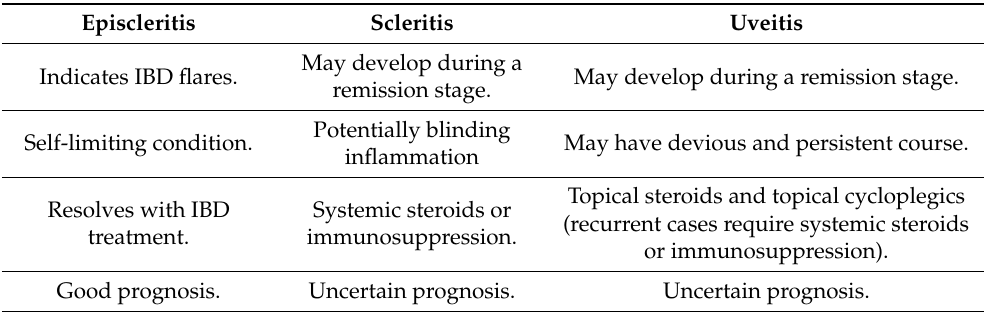
Table 1. Ophthalmic manifestations in inflammatory bowel